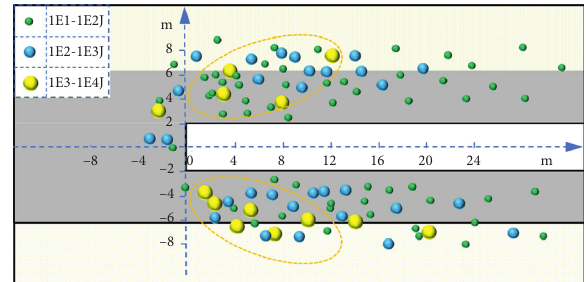
Figure 3: Spatial distribution of near-field seismic events in the driving